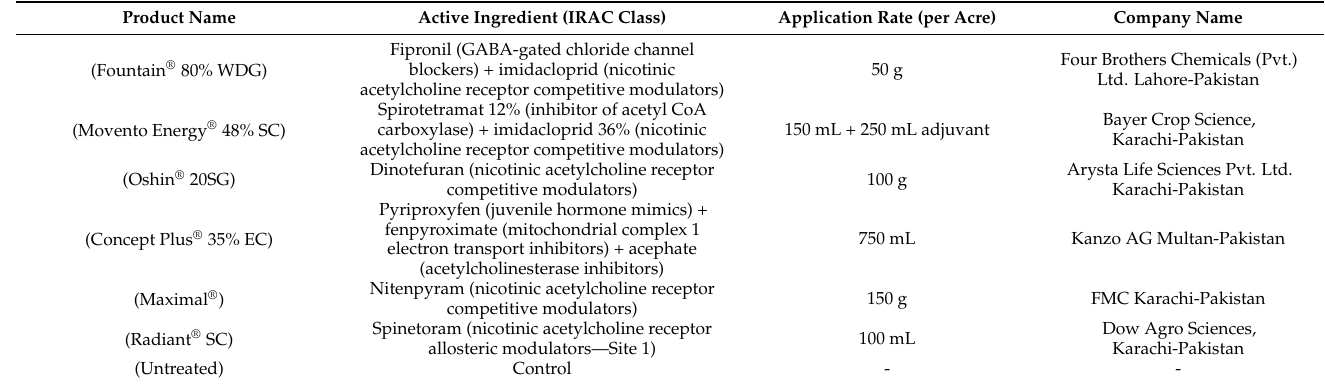
Table 1. List of insecticides used in experimental field plots and their rates of application to the cotton